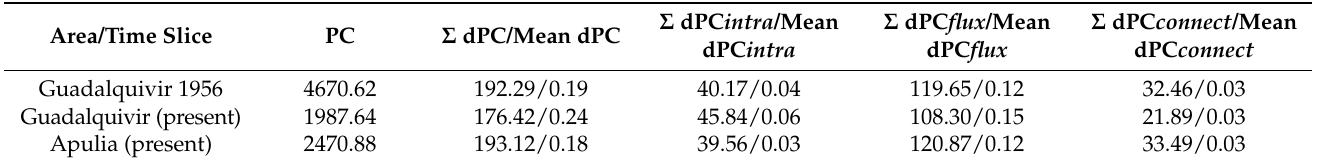
Table 3. Results of the fragmentation analysis. Values for PC (Probability of Connection), dPC and mean, with the three components of dPC (dPC intra , dPC flux, and dPC connector